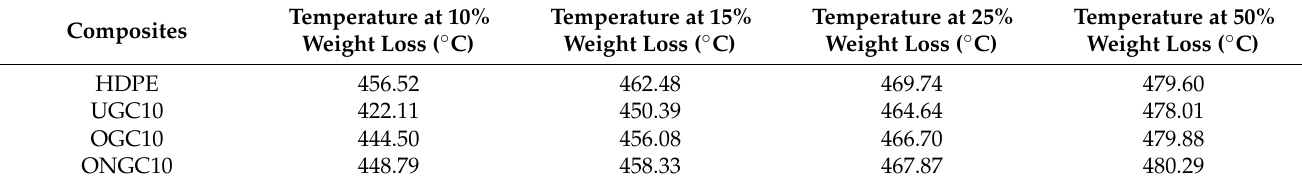
Table 6. Degradation temperature of HDPE, UGC, OGC and ONGC (10% particle